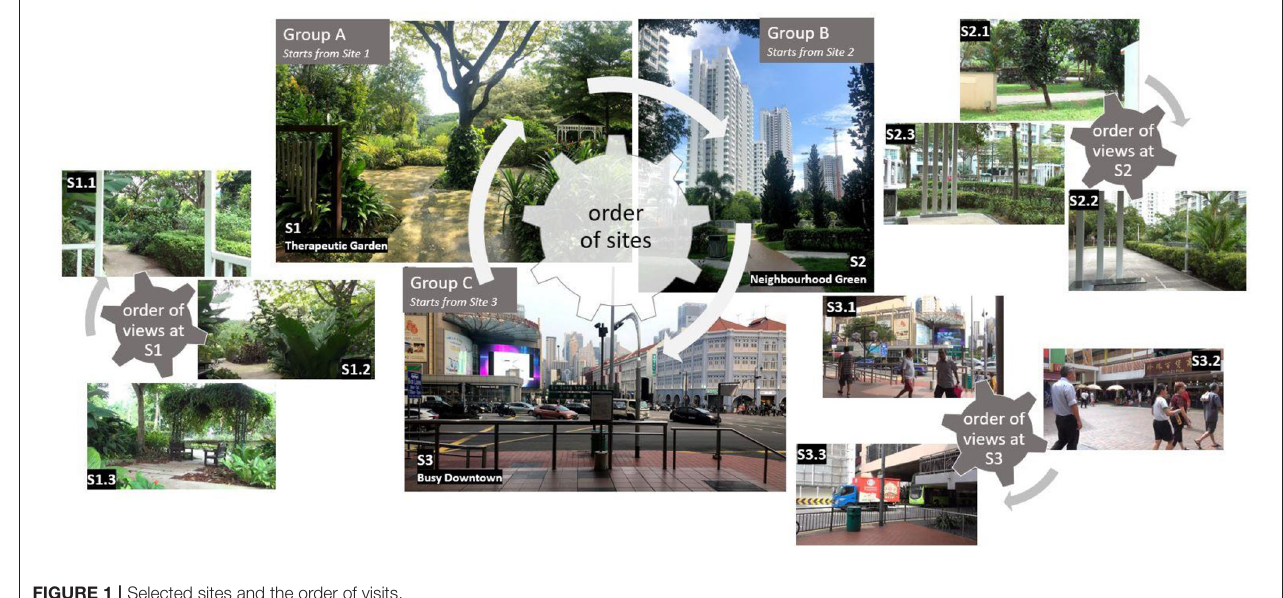
FIGURE 1 | Selected sites and the order of visits.